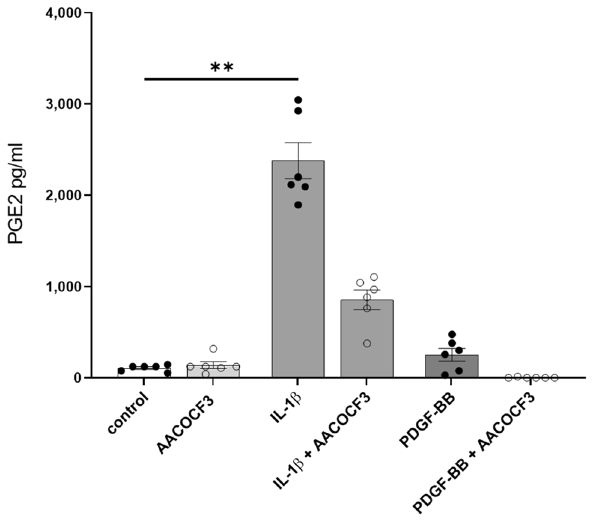
Figure 6. Inhibition of cPLA2 with AACOCF3 1 μM reduces IL-1β, PDGF-BB induced PGE2 secretion. ** P < 0.01. Data are reported as mean ±